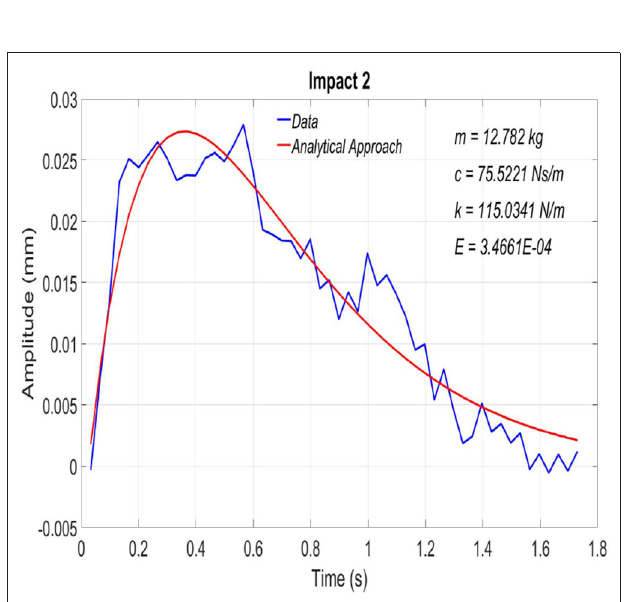
is rightly reproduced with the proposed analytical